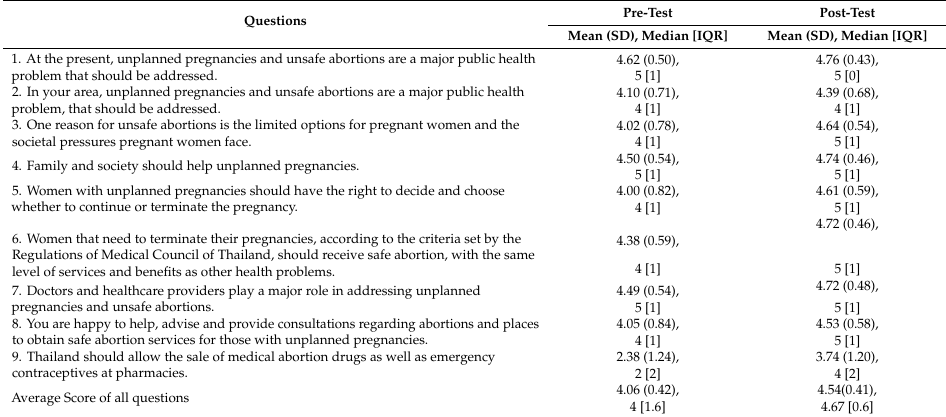
Table 2. The comparison of the pre- and the post-test attitudes towards adolescents and women experiencing unplanned pregnancies and unsafe abortions ( n =